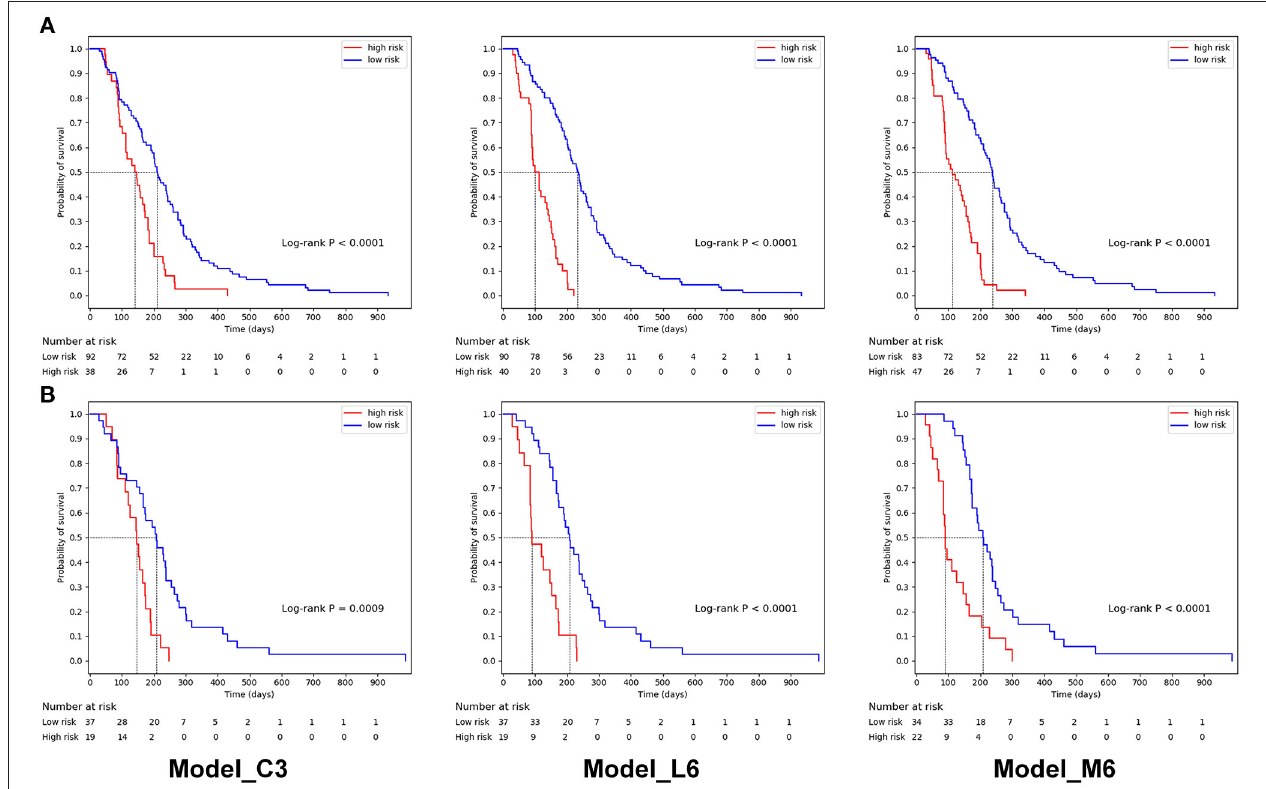
FIGURE 4 | Kaplan–Meier progression-free survival curves of prognostic models based on 3 clinical features (Model_C3), 6 lung window features (Model_L6), and mediastinal window features (Model_M6) for patients in (A) the training set and (B) the independent test set. In the training set, the median PFS were 211, 233, and 238 days for the low-risk group and 140, 99, and 112 days for the high-risk group. In the independent test set, the median PFS were 209, 209, and 209 days for the low-risk group and 147, 91 and 90 days for the high-risk group.